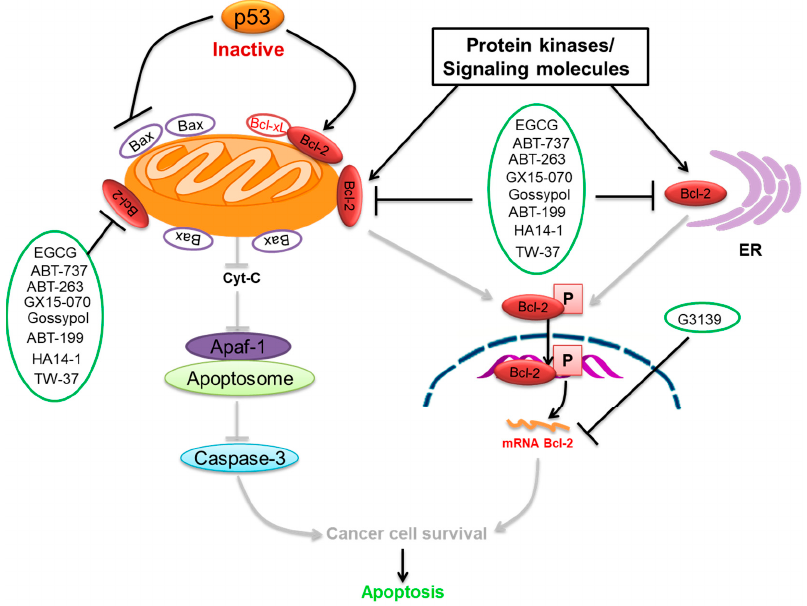
Figure 4. Bcl-2-mediated apoptosis cascade and the mechanism of action of inhibitors. Over-expression of Bcl-2 might be blocked and inhibited through Bcl-2 inhibitors. Inhibitors block cancer progression by targeting signaling molecules or protein kinases that abrogate Bcl-2 expression and decrease the expression of Bcl-2 by inhibiting cell growth and proliferation and initiating apopto- sis.